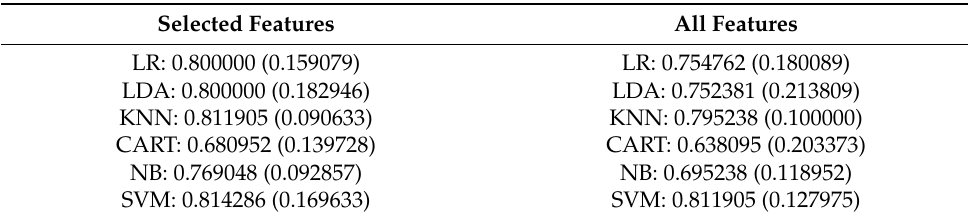
Table 10. ACTH: results of machine learning algorithms for all features and for the feature reduction situation with only relevant